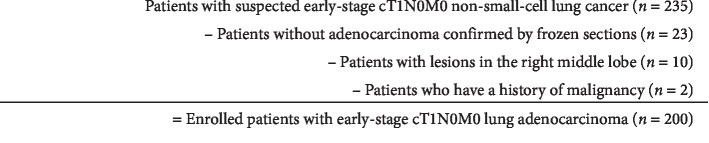
Selection procedure for all 200 enrolled cases.